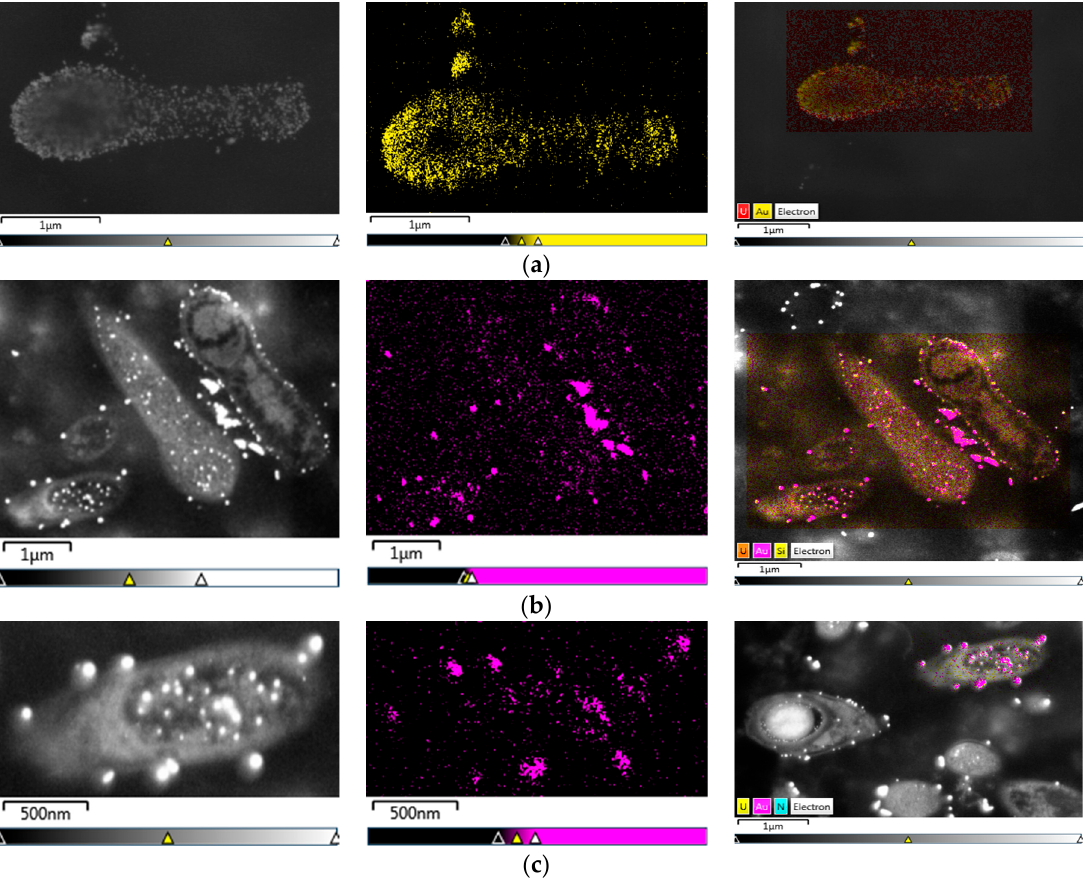
Figure 5. SEM and EDS analysis maps for samples of the mix between Lysinibacillus sphaericus MCB1 and MCB2 prepared in resin. Slides of 70 nm show cells ( a , b ) in different sporulation stages and in ( c ) a vegetative cell.